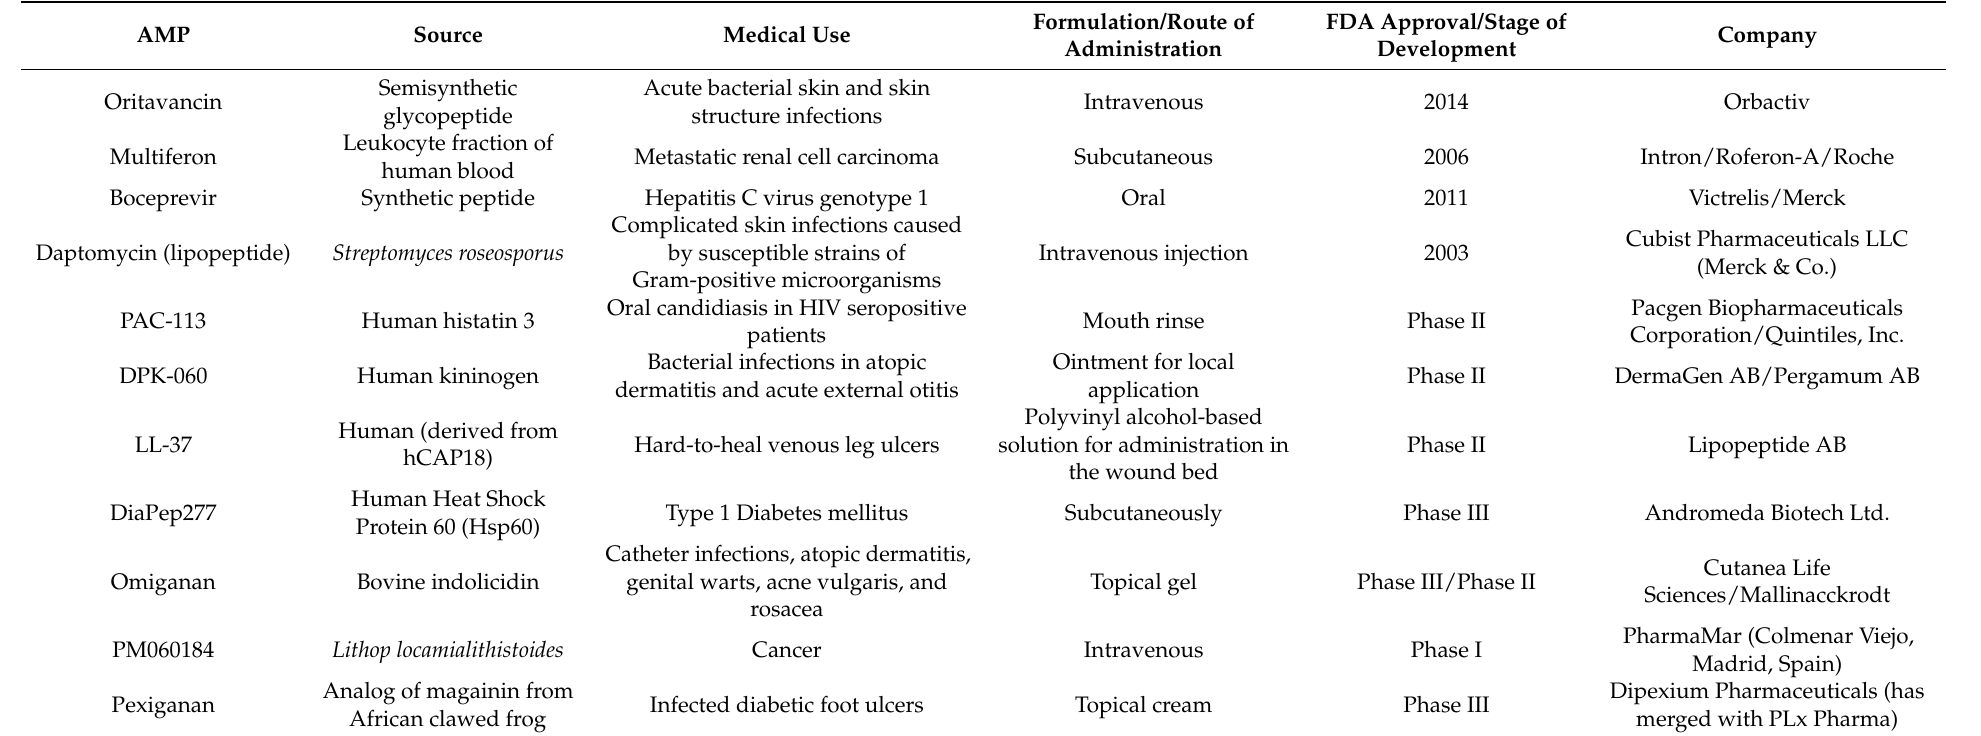
Table 1. List of AMP in clinical trials and Food and Drug Administration (FDA) approved AMP for various human infections and diseases